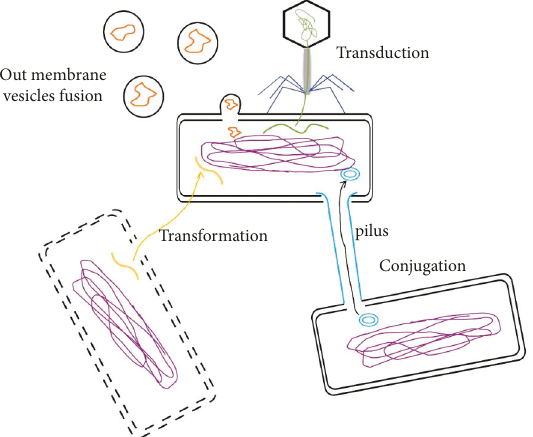
Figure 1: General ways of horizontal gene transfer. Conjugation, Transformation, Transduction, and Out membrane vesicles fusion. Yellow represents DNA fragments; blue represents conjugation elements (ICEs); orange represents membrane vesicles